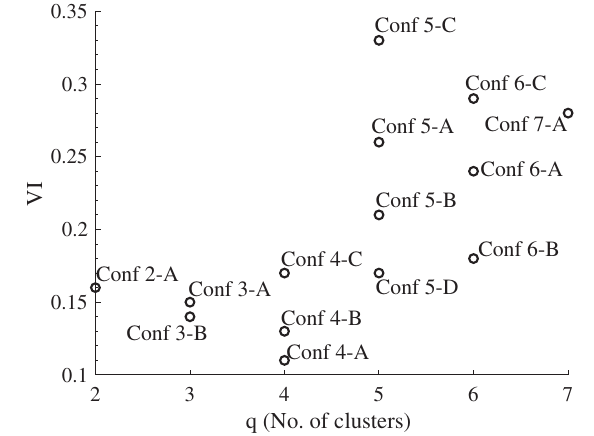
FIG. 12. VI values calculated between the 3-cluster results of the k -means method and each of the clustering results of the H -CLA method, as summarized in Table VI. The x axis reports the number of clusters in the various H -CLA results.